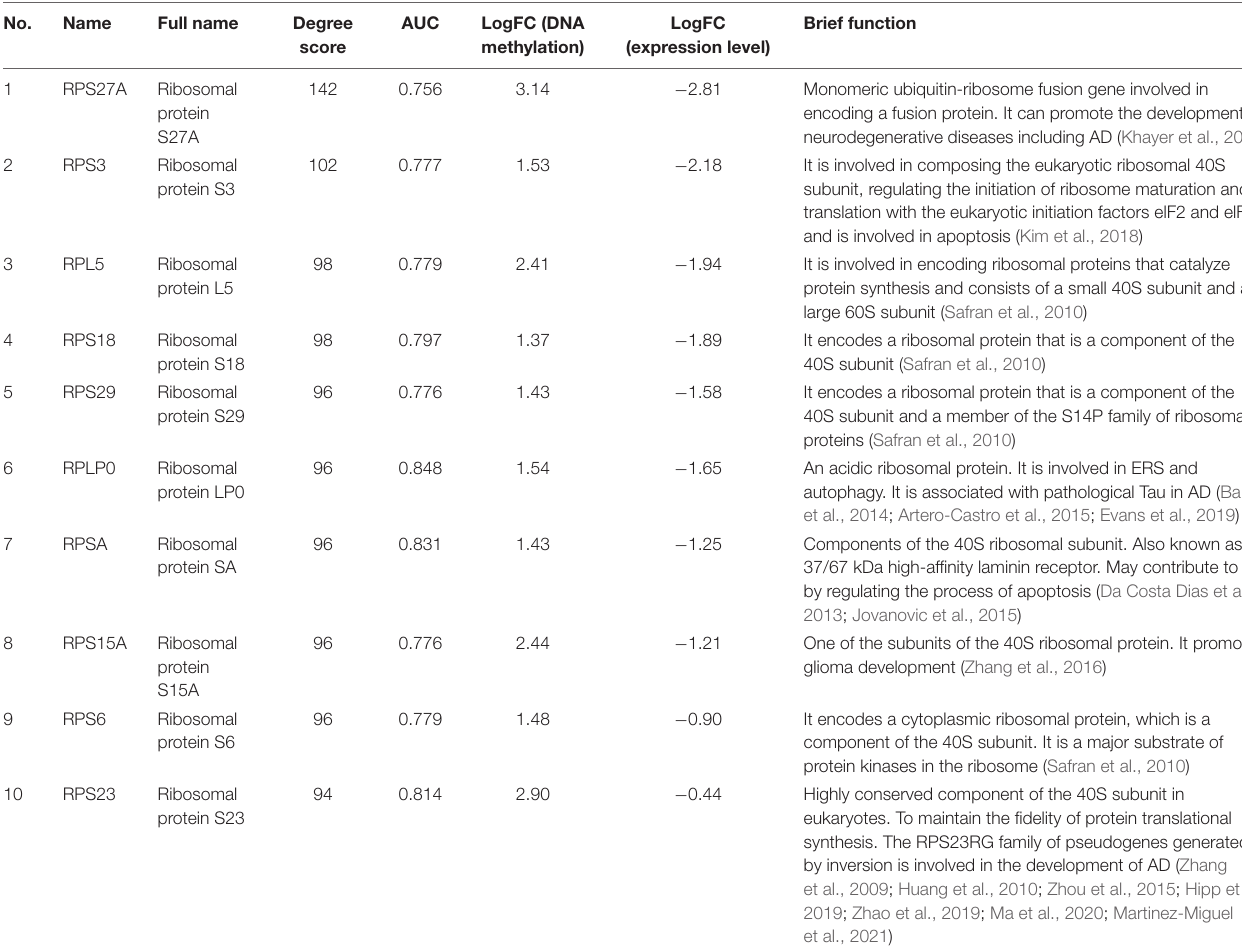
TABLE 4 | The information of top 10 hub